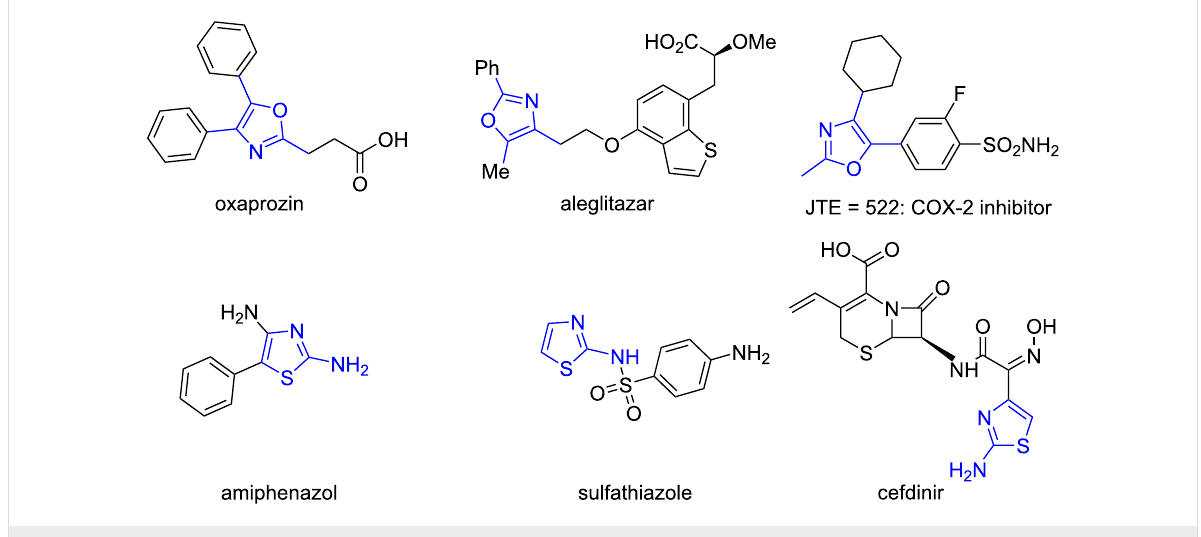
Figure 1: Examples of biologically active oxazole and aminothiazole scaffolds.